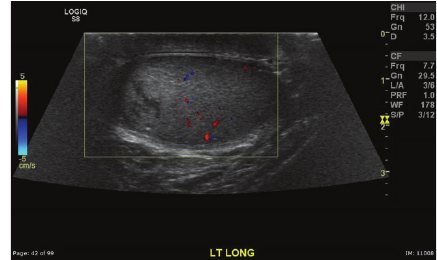
Figure 1: Color-Doppler ultrasound image of the left testis shows an avascular echogenic lesion with hypoechoic center.